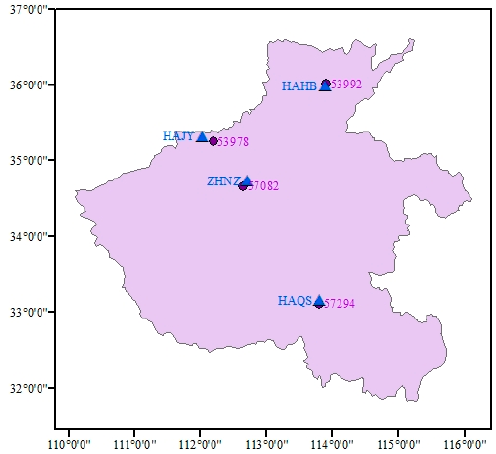
Figure 3. Distribution of rainfall in Henan Province from 19 July to 22 July: ( a ) Rainfall distribution on 19 July; ( b ) Rainfall distribution on 20 July; ( c ) Rainfall distribution on 21 July; ( d ) Rainfall distri- bution on 22 July.